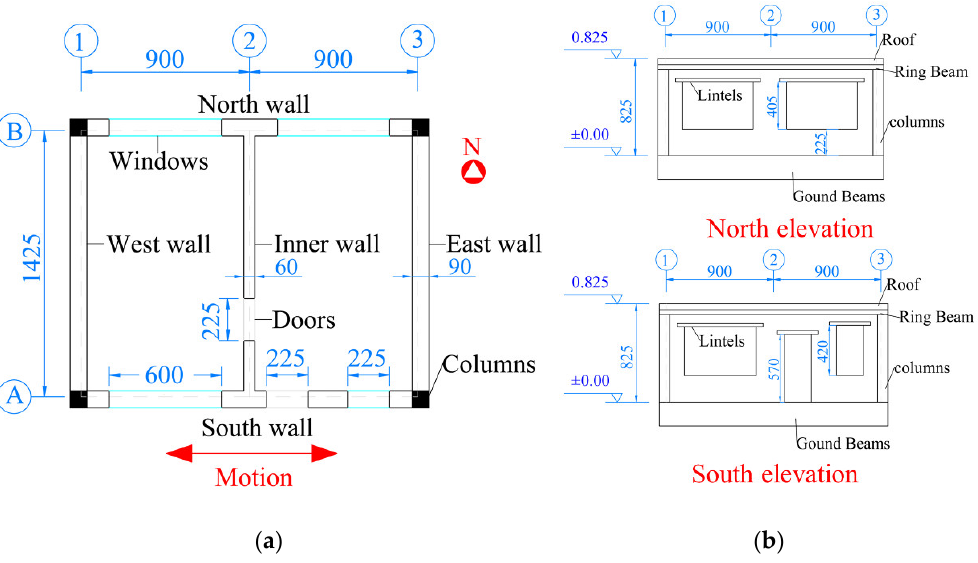
Table 1. Similarity ratios of the structural model.